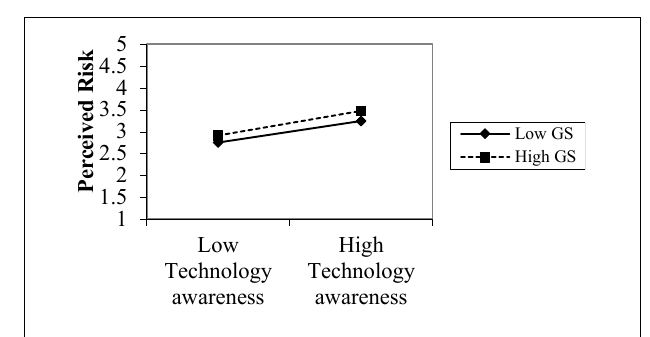
FIGURE 4 | Moderating role perceived